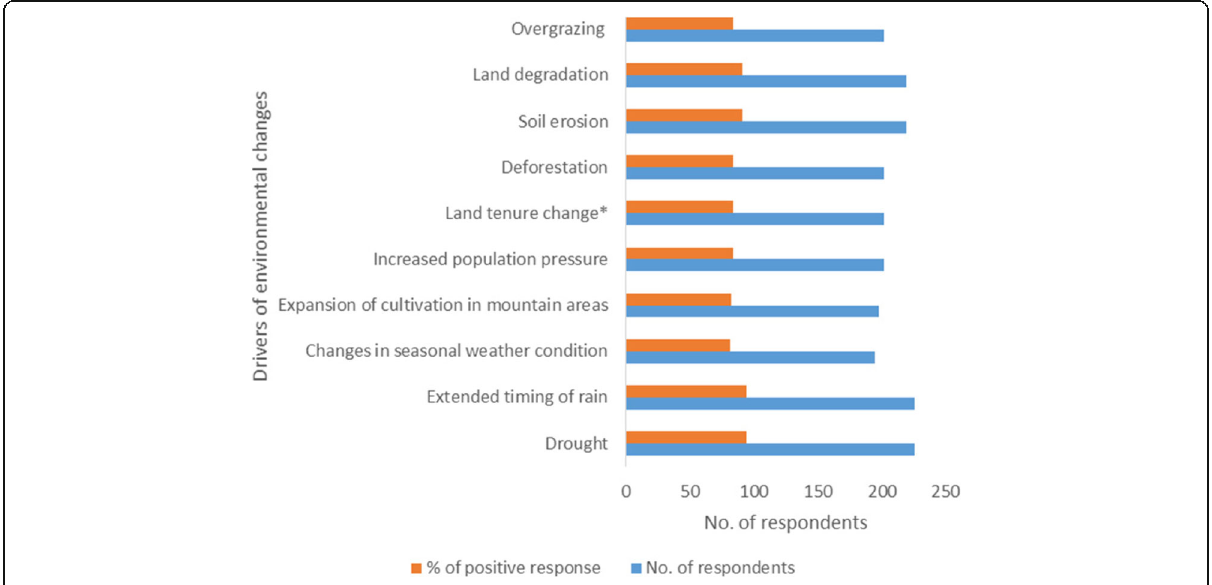
Fig. 3 Communities ’ perceptions on drivers of land use/land cover changes in Sidama, southern Ethiopia